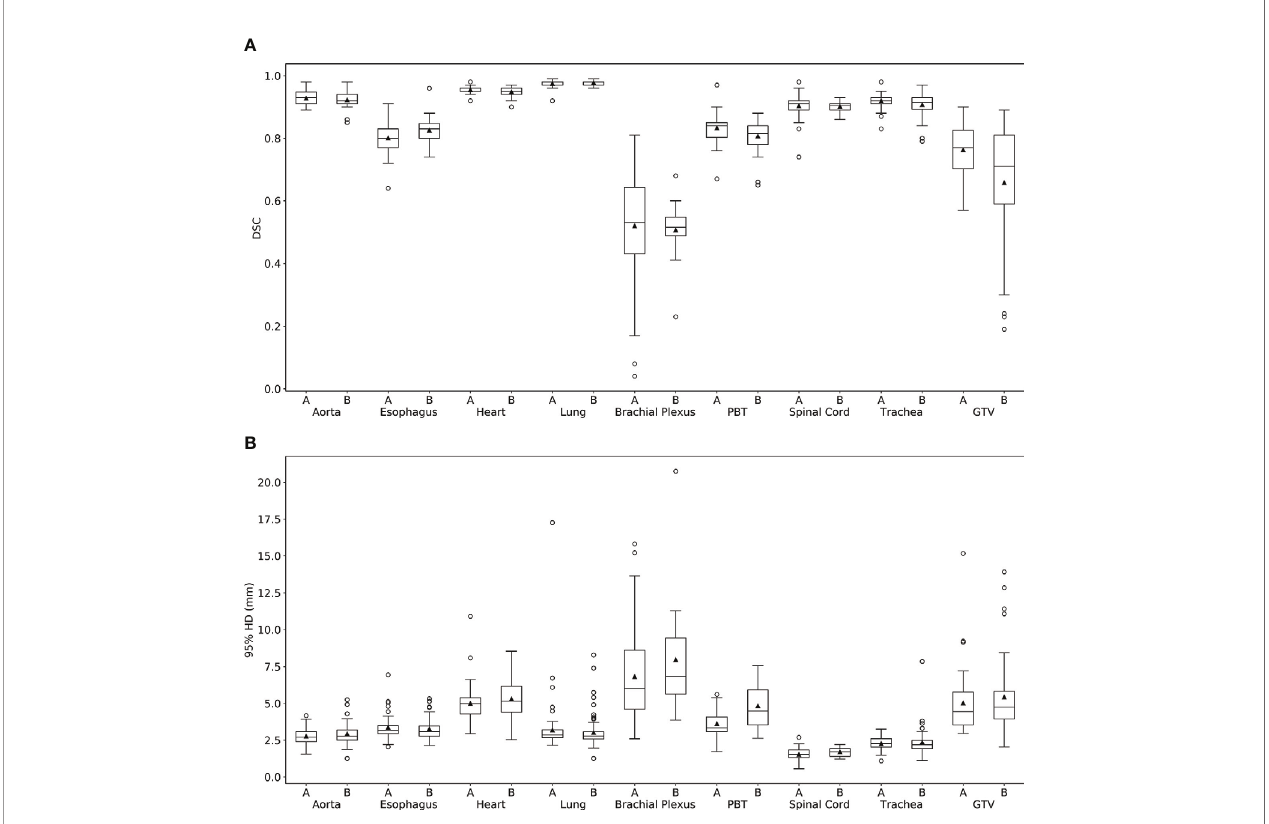
FIGURE 2 | Dice Similarity Coef fi cient (DSC) and 95% Hausdorff distance (HD) box plots from comparing deep learning-based auto-segmented contours to clinical contours for center (A) and center (B) lung stereotactic ablative radiotherapy planning structures. (PBT, proximal bronchial tree; GTV, gross tumor